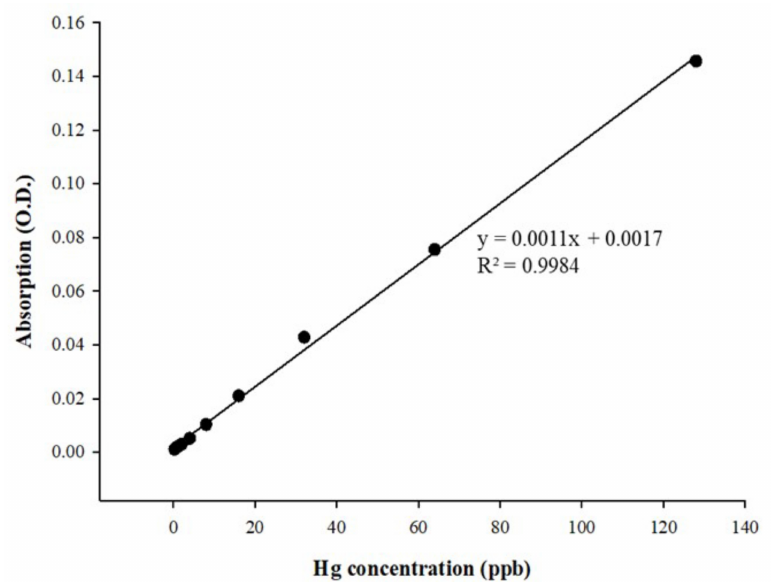
Figure 9. Linear calibration curve of mercury (Hg) obtained using atomic absorption spectroscopy (AAS) assay. The concentration of mercury (Hg) ranged from 0.25 to 128 ppb. The regression value was 0.9984 (R 2 >